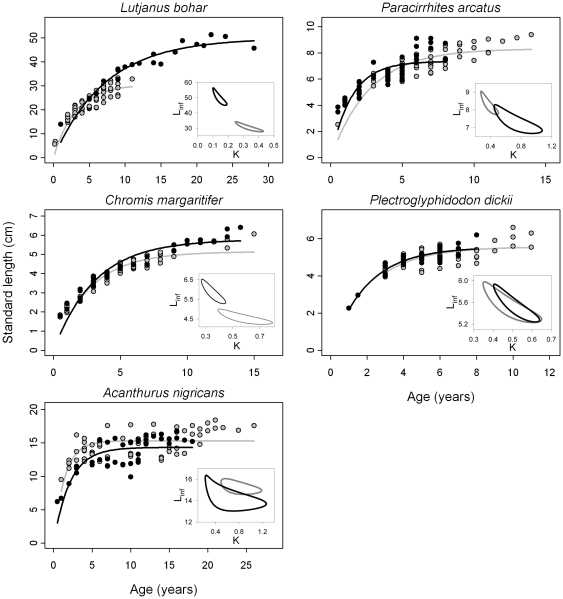
Size-at-age relationships for the 5 study species by island, with lines of best fit for VBGF parameters.Inset plots for each species show 95% confidence ellipses for the parameters k and Linf. Shading for histogram bars as in Fig. 2.